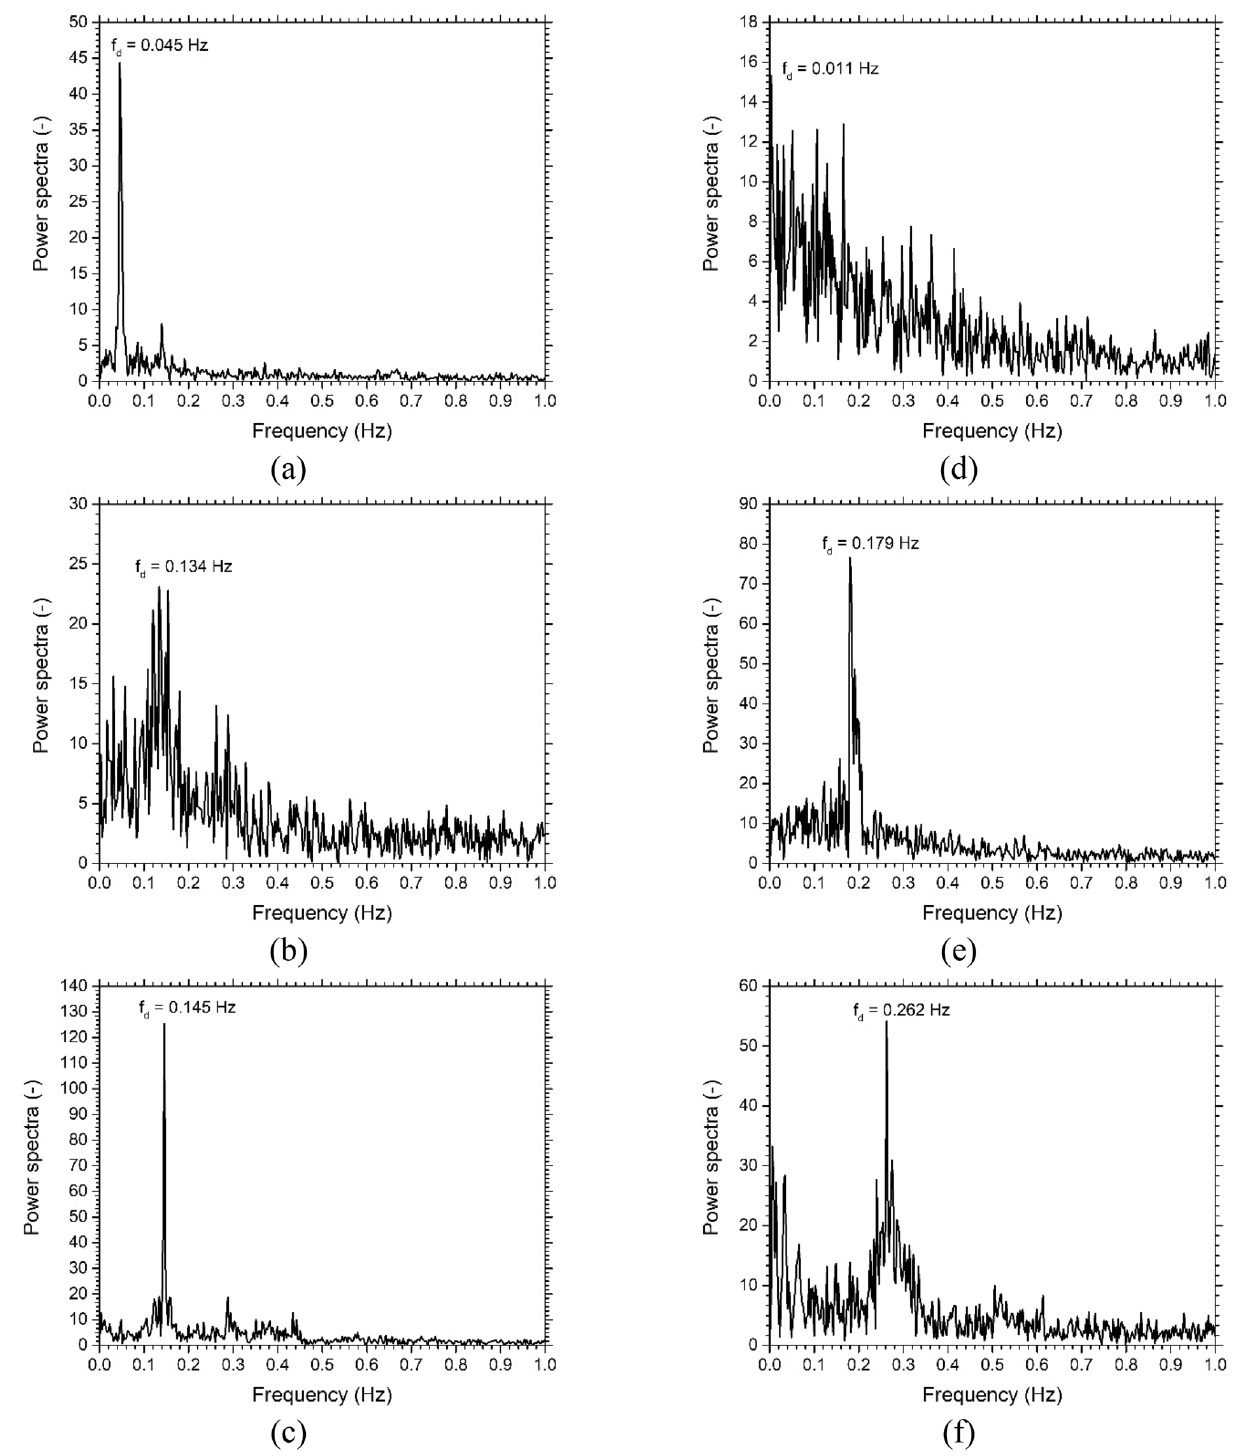
c A7 (18%), 2 mm bubble, d A1 (100%), 8 mm bubble; e A4 (69%), 8 mm bubble, f A7 (18%), 8 mm bubble (U